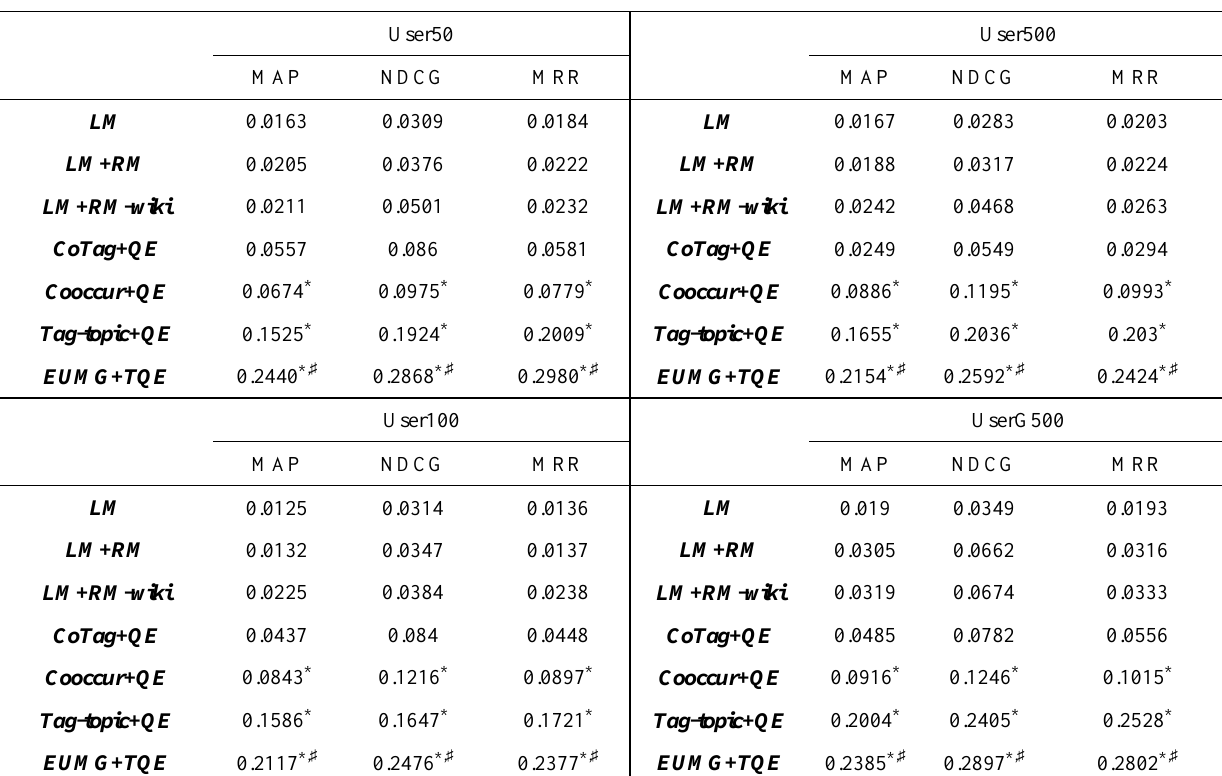
Table 3 . Evaluation results of various methods on DEL colletion. Statistically significant differences between a method with the best performing non-personalized baseline ( LM+RM-wiki ) and the best performing personalized baseline ( Tag-topic+QE ) are